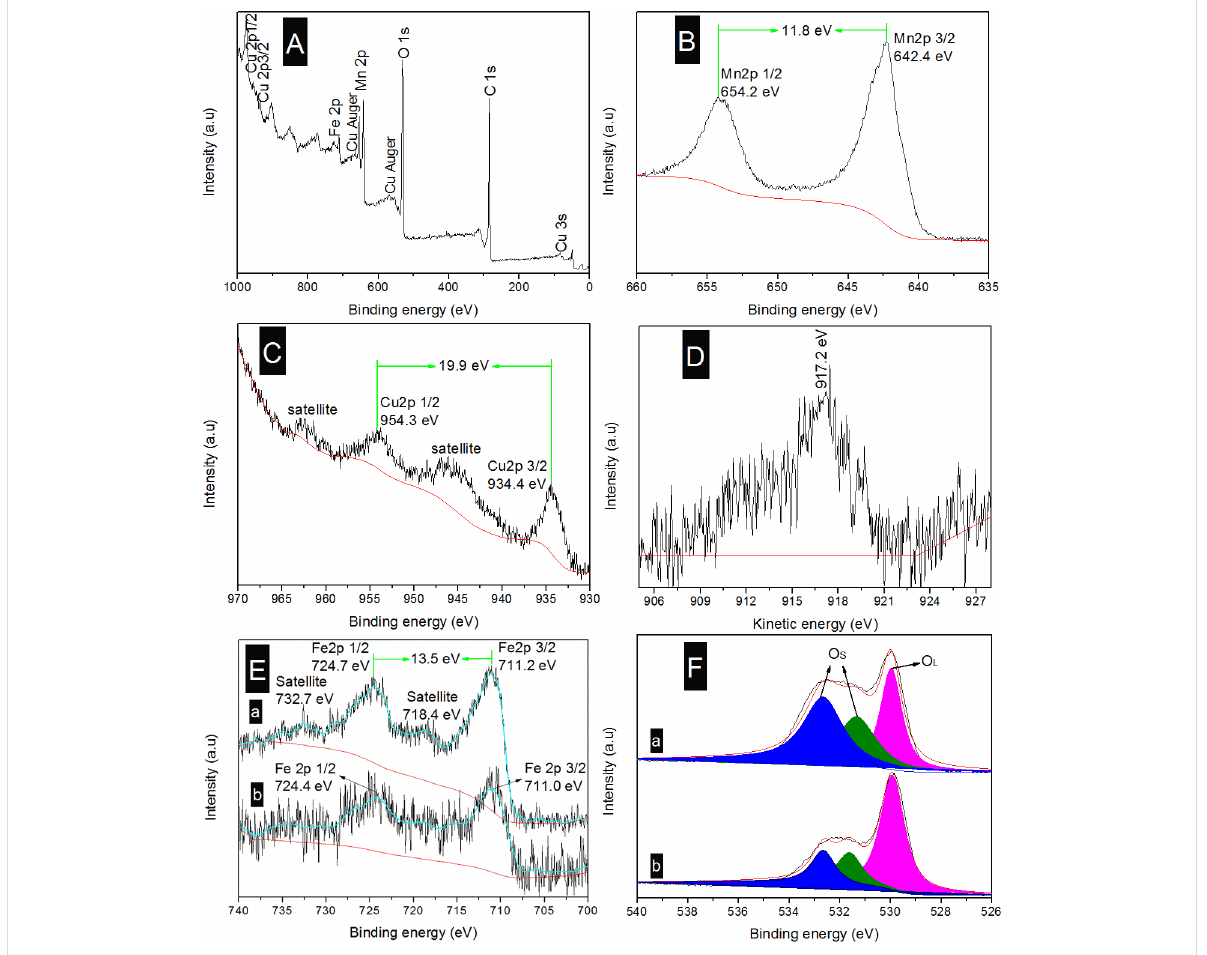
Figure 4: XPS results of the as - prepared catalysts: (A) XPS full - scan spectrum, (B) Mn 2p, (C) Cu 2p, and (D) Cu Auger spectra of 4% MnO 2 –CuO–Fe 2 O 3 /CNTs; (E) Fe 2p and (F) O 1s spectra for (a) 4% MnO 2 –CuO–Fe 2 O 3 /CNTs and (b) Mn–Cu–FeO x /CNTs - IWIM.